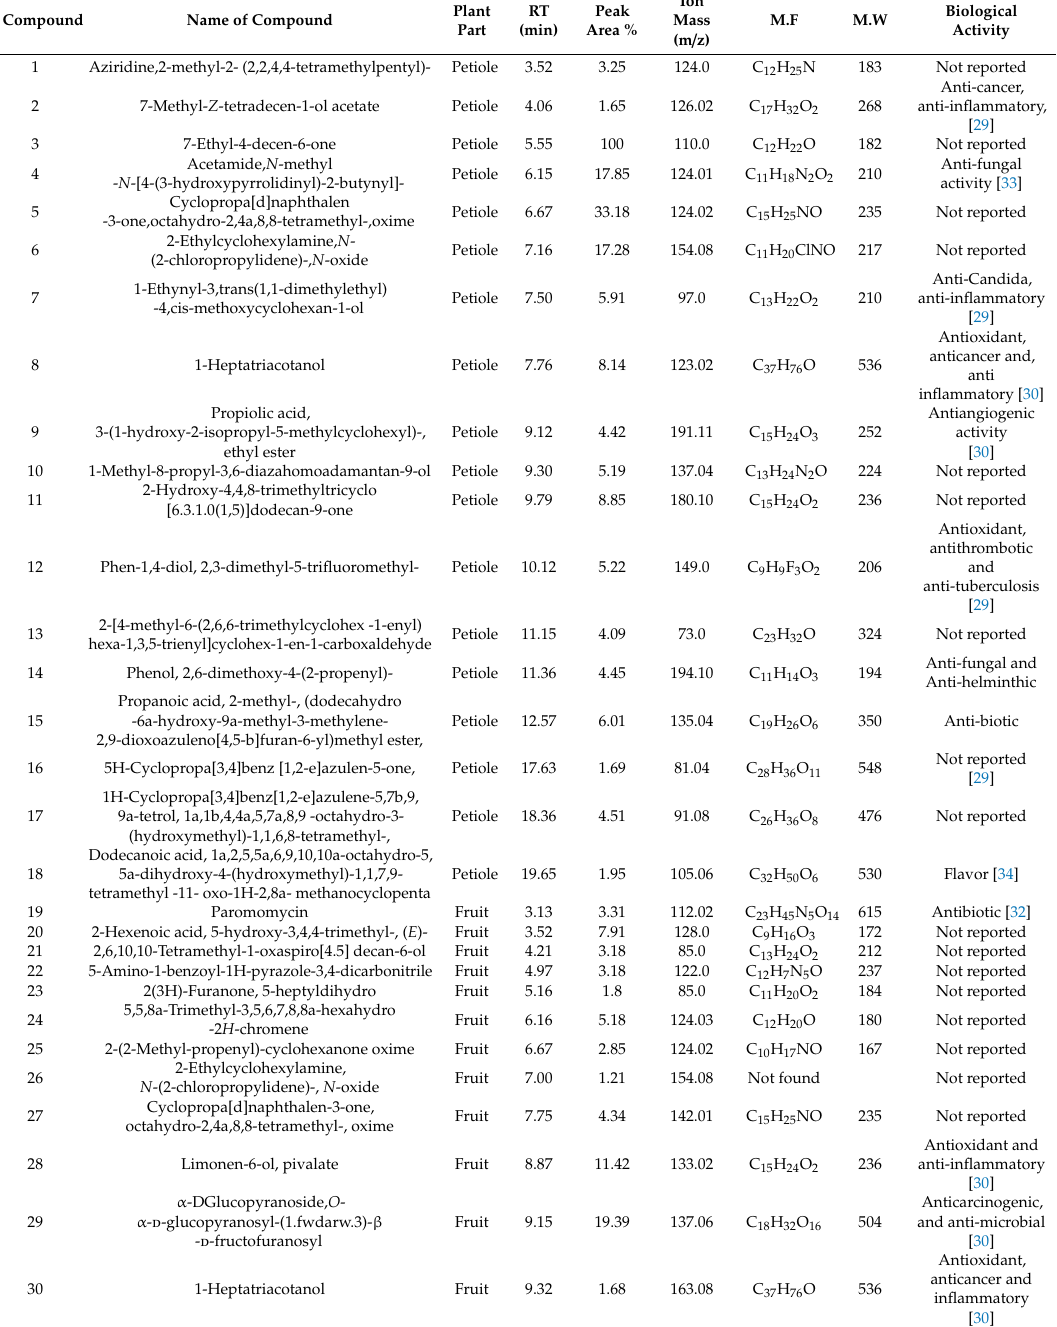
Table 3. List of compounds from ethanolic petiole and fruit extracts observed in GC-MS with their retention time and biological